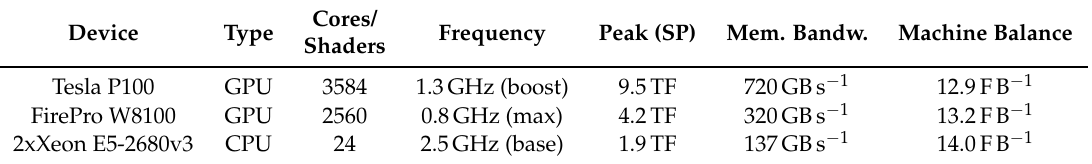
Table 2. The hardware platforms used in the distributed and node-level experiments. We list the frequency type that best matches our observations during the experiments. Cores/ Device Type Frequency Peak (SP) Mem. Shaders